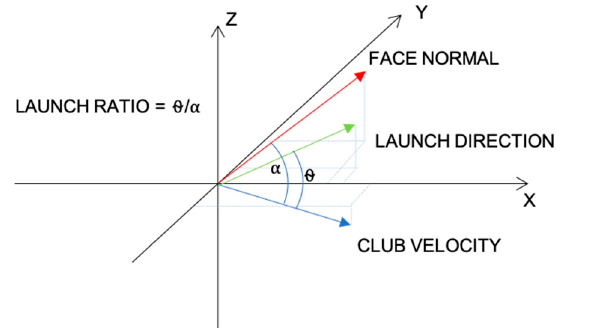
Figure 1. Depiction of the launch ratio